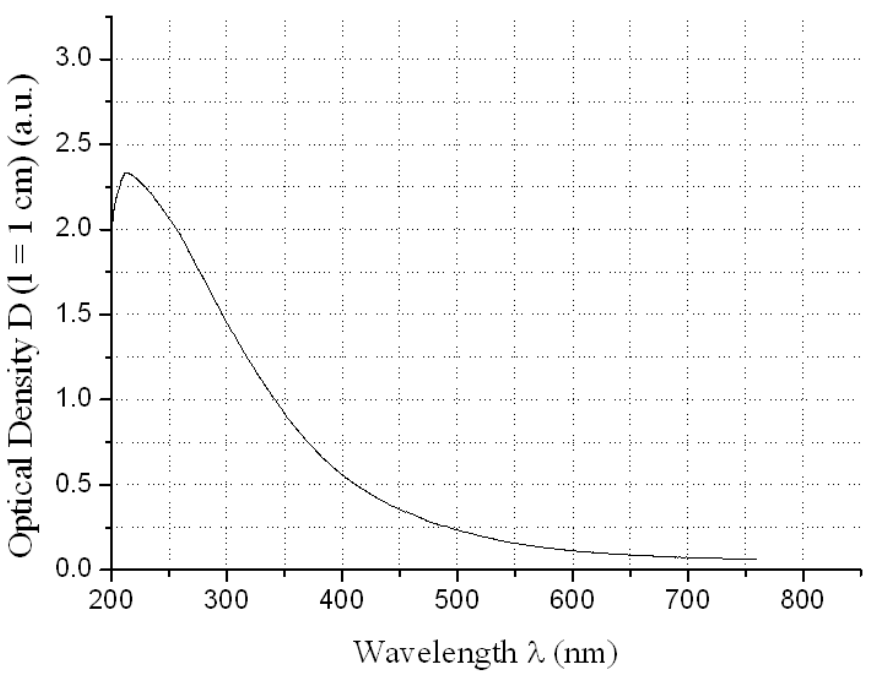
Figure 1. Electronic spectrum of water solution of C 60 (OH) 24 at concentration C C60(OH)24 ≈ 0.625 g/dm 3 relatively distilled H 2 O.